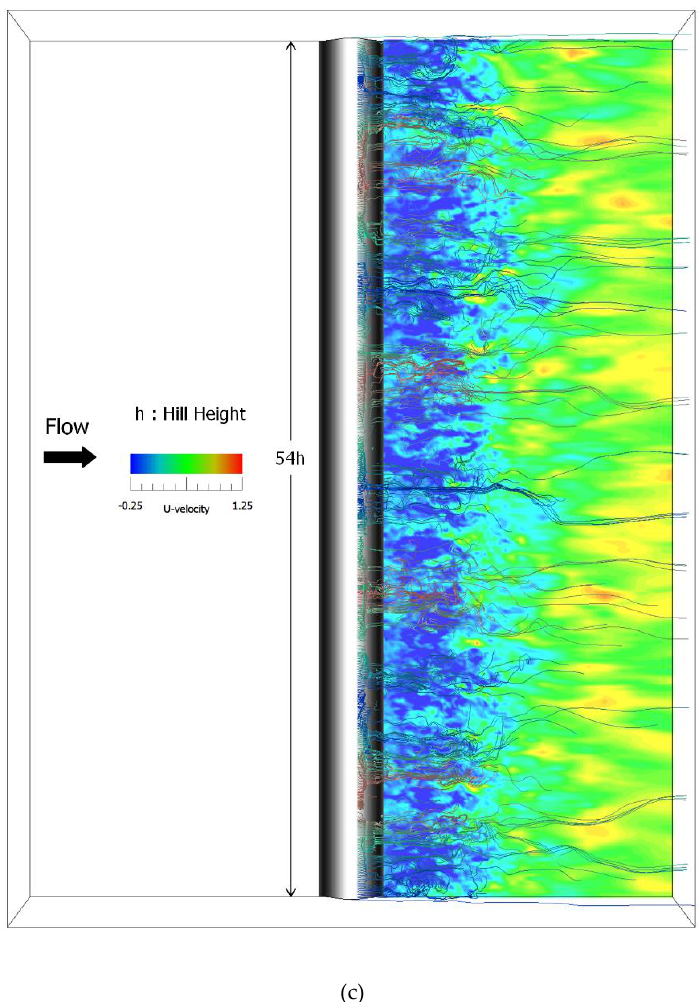
Figure 8. Instantaneous flow pattern around a two-dimensional ridge model (streamlines, top view): Figure 9 shows streamlines for the flow field with temporal and spanwise spatial averaging.